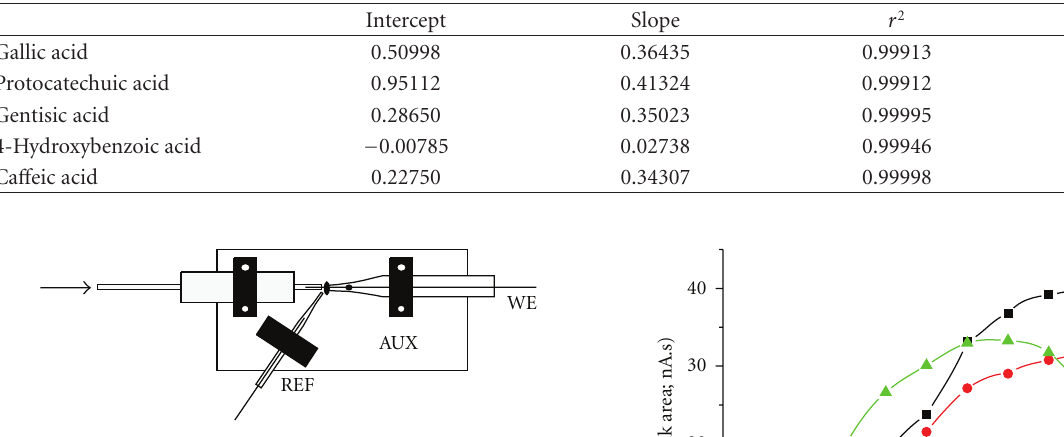
Figure 3: Scheme of the electrode arrangement used for HPLC measurements. E ffl uent flow direction is indicated by the arrow.